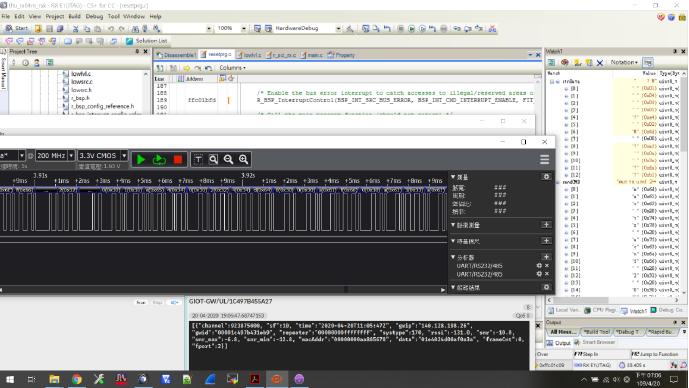
Figure A4. The total responses diagram of Water sensor, RX64M and RoLa